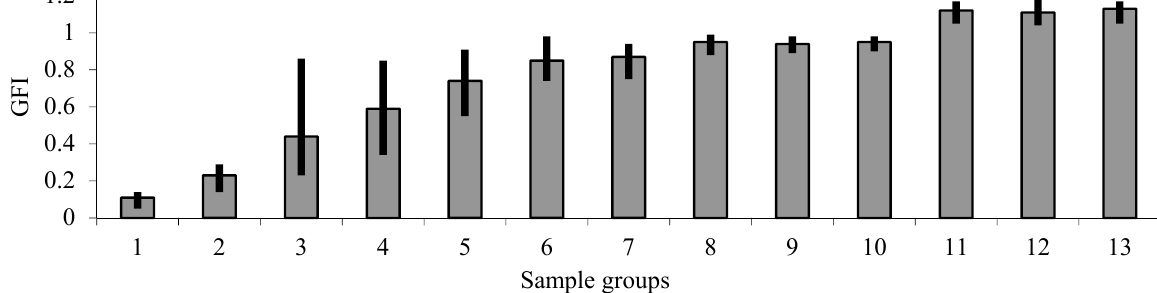
Fig. 4. Value of the glucose-fructose index (GFI) in liqueur wines and falsifications (the list of samples groups is provided in the methodological part, Table